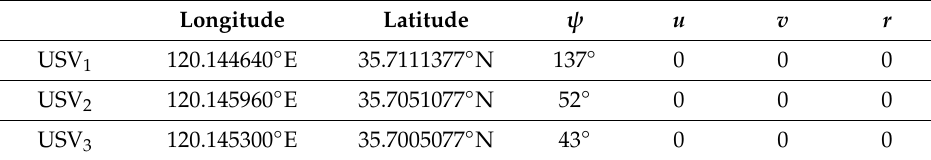
USV on basestation . 1